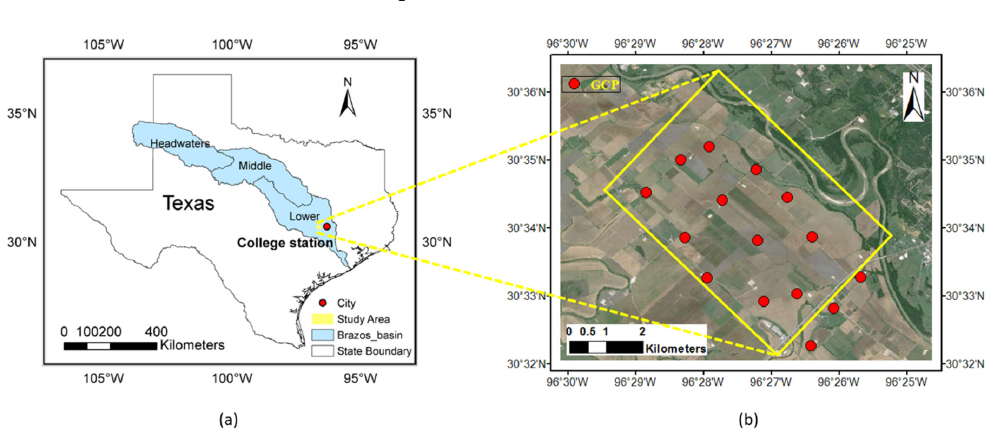
Figure 1. The study area: ( a ) Geographic map of the study area, which is located in the bottom of Brazos basin and near College Station, Texas; and ( b ) image map of the study area from Google Earth.